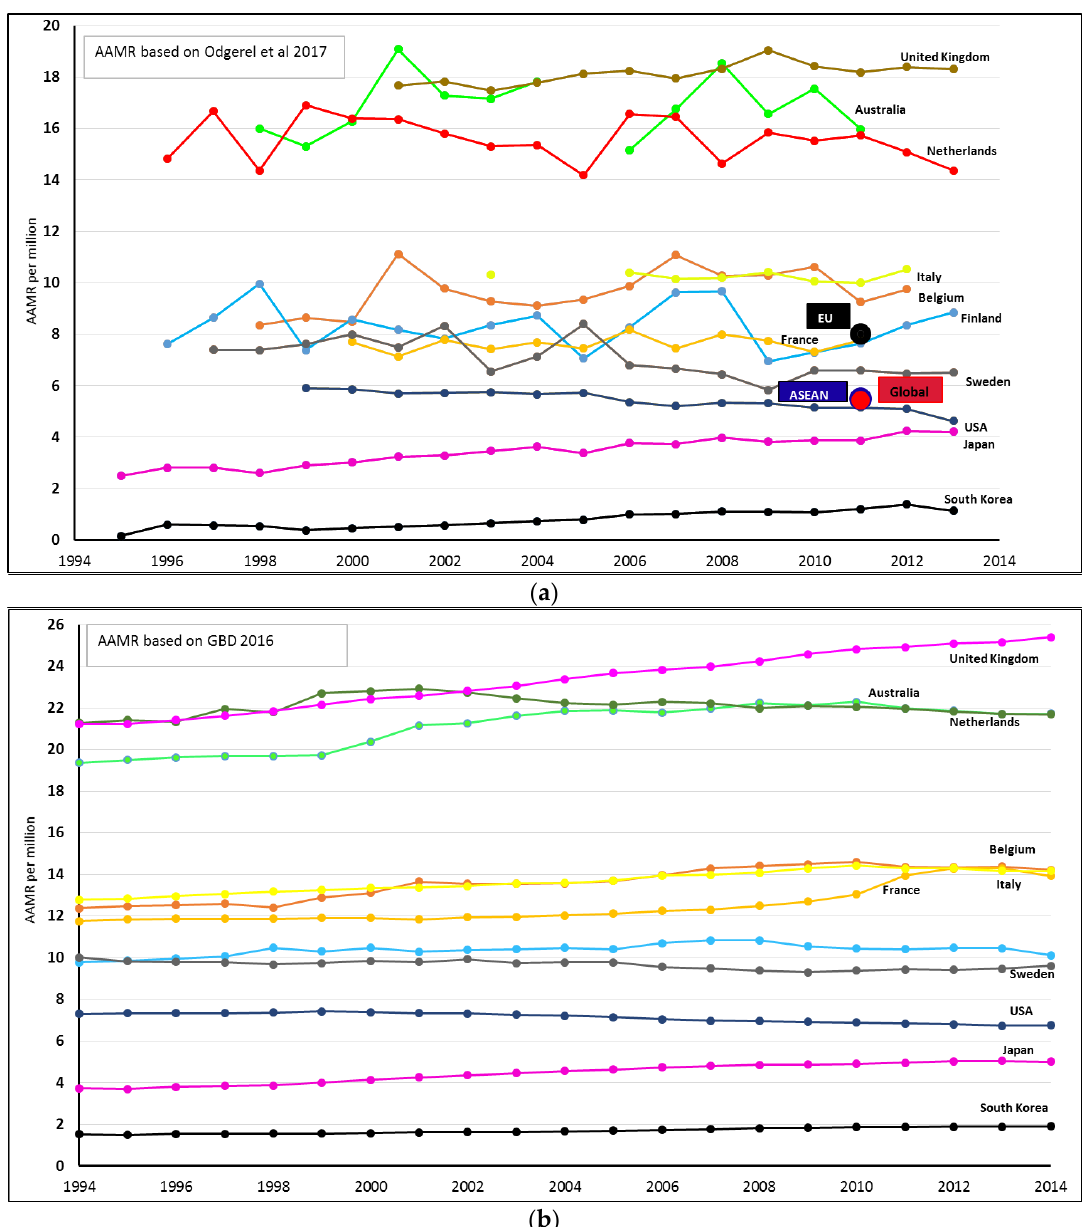
Figure 4. Age-adjusted mortality rate of mesothelioma for selected countries based on Odgerel C-O 2017 [6] ( a ); GBD 2016 study [10] ( b ).